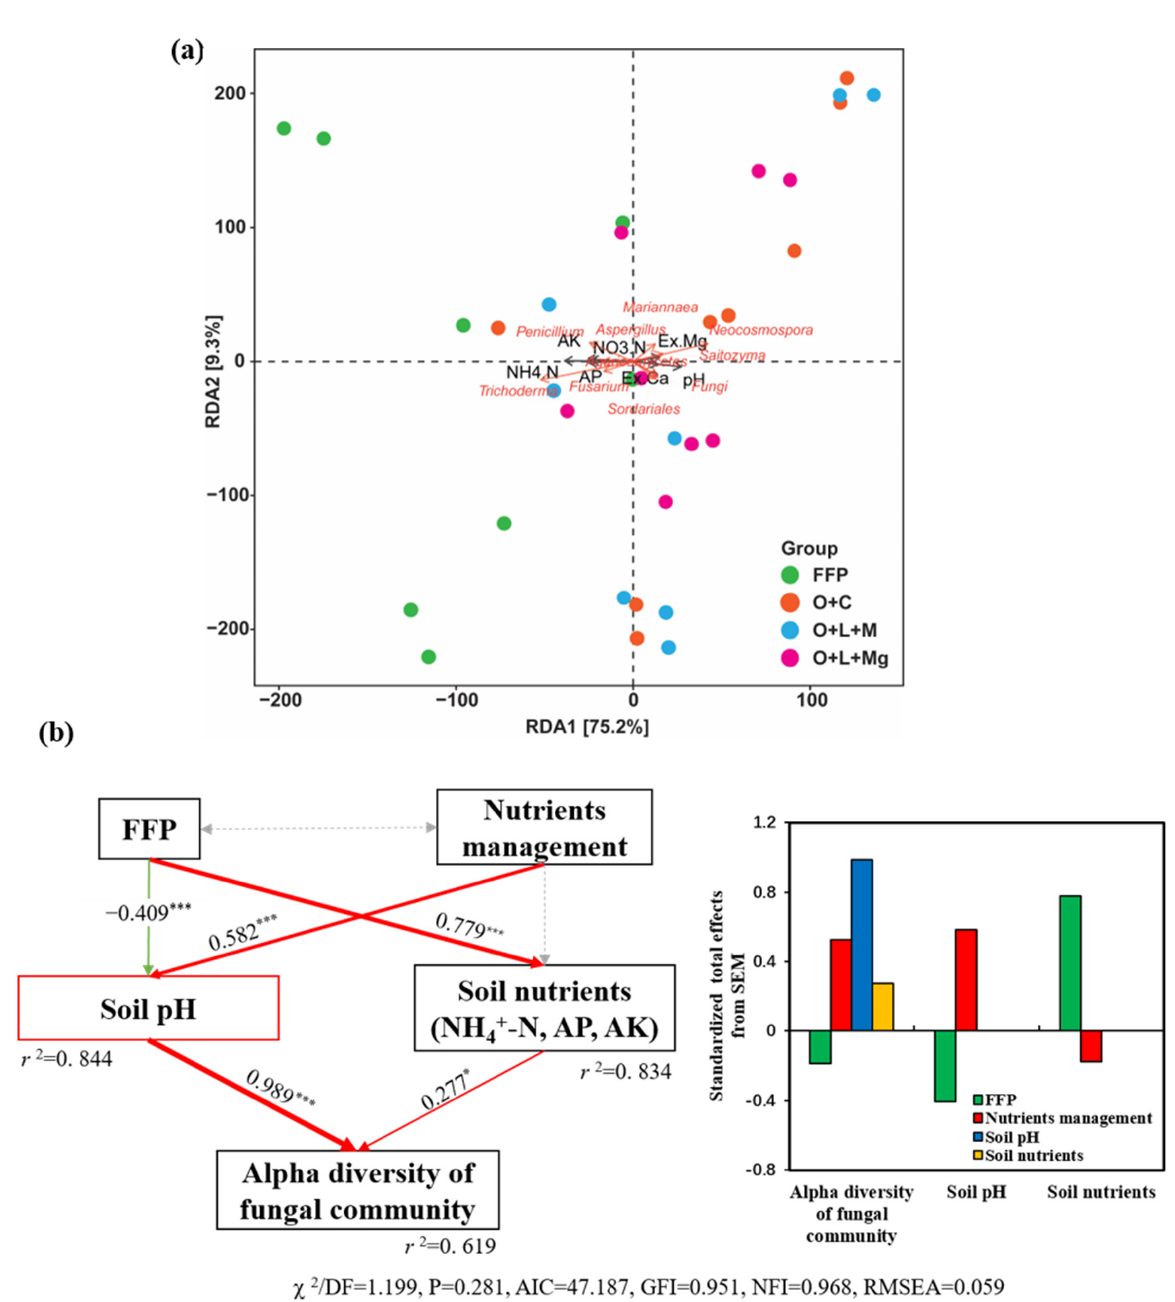
Figure 5. Effect of soil properties on soil fungal communities. The effects of soil properties were evaluated on soil fungal communities: ( a ) distance-based redundancy analysis (RDA); ( b ) structural equation model (SEM). In the SEM, the levels of significance are denoted by * p < 0.05, *** p < 0.001. The R 2 values denote the proportion of the variance explained by each variable. The standardized total effects calculated by the SEM are shown below the SEM. The low value of normed chi-square: ( χ 2 /DF, <2), nonsignificant probability level ( p > 0.05), low Akaike information criteria (AIC), high normed fit index (NFI > 0.90), and low value of root-mean-square error of approximation (RMSEA < 0.05) listed below the SEMs show that our data matched with the hypothetical models. Table 3. Pearson correlation between the Bray–Curtis dissimilarity score and soil characteristics using the Mantel test. Variable Name